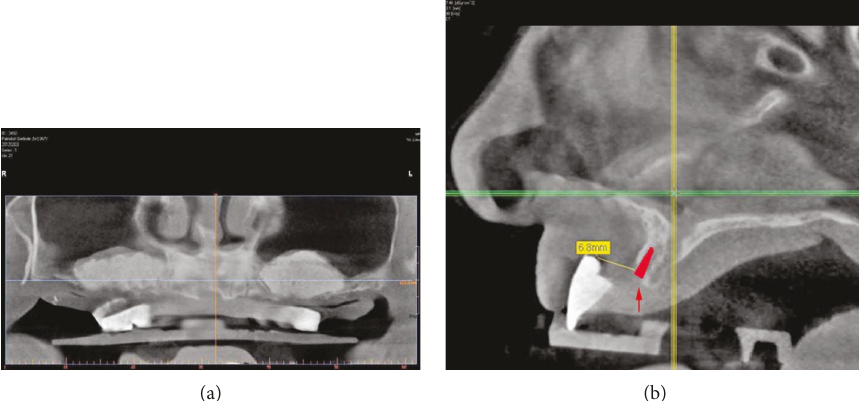
Figure 5: Implant planning. CBCT of the maxilla with DentDu-Brm in situ before implant placement: (a) sagittal section and (b) axial section.